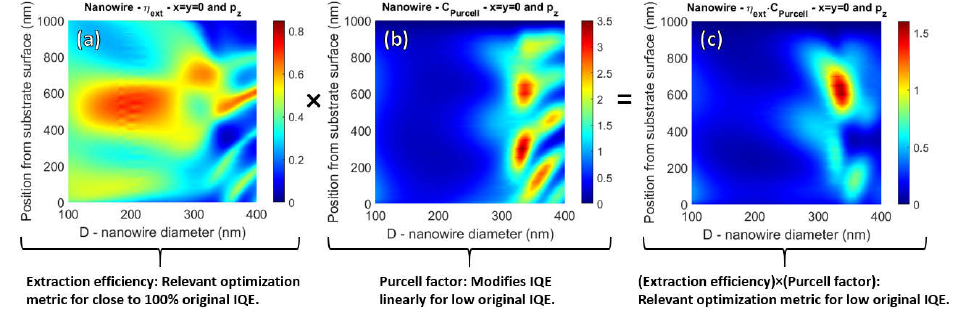
Figure 7. ( a ) Extraction efficiency, η ext , ( b ) Purcell factor, C Purcell , and ( c ) η ext C Purcell of a nanowire.